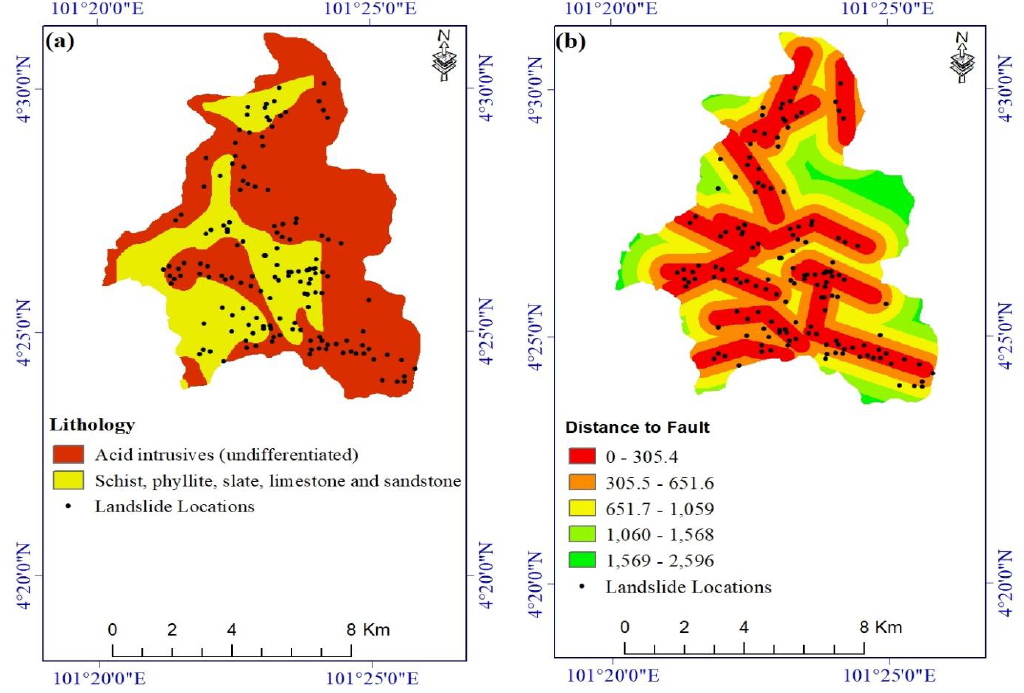
Figure 5. Landslide conditioning factors: ( a ) lithology and ( b ) distance to fault.